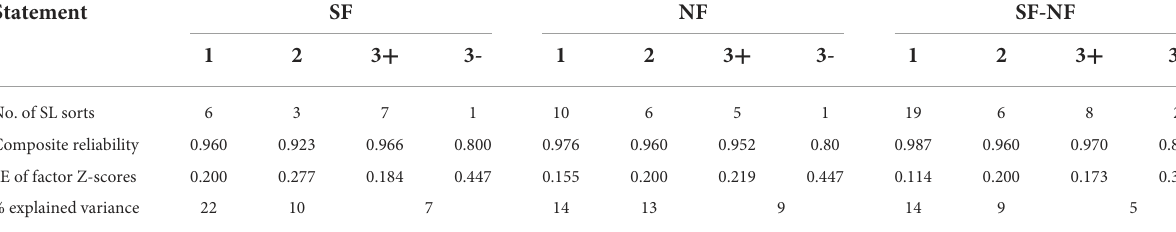
TABLE 6 Factors